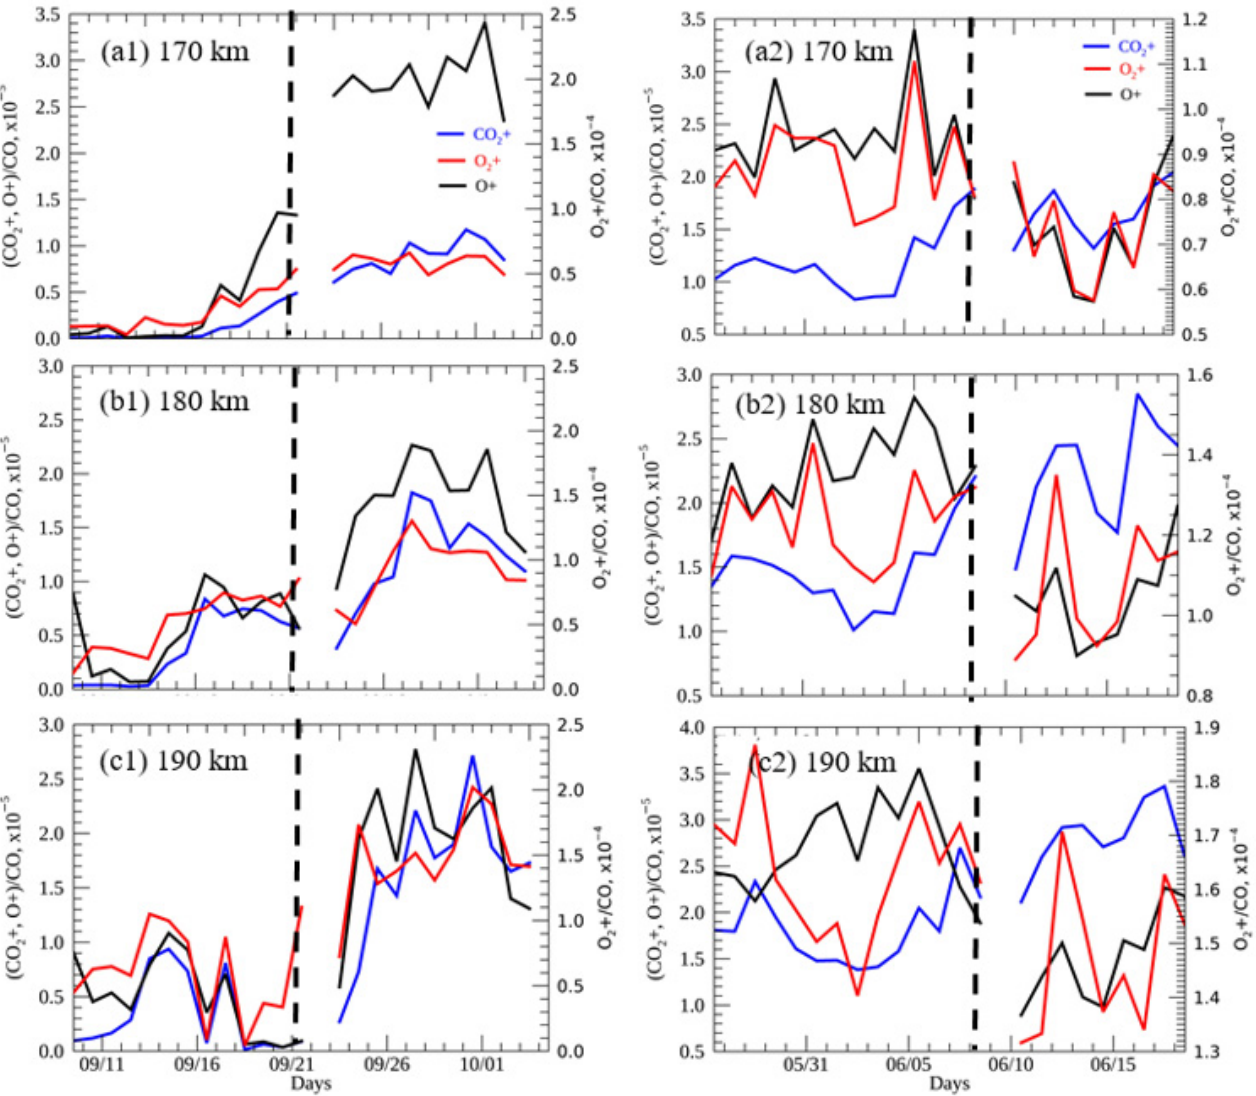
Figure 7. Ratio of (O 2+ , CO 2+ , and O + ) to CO at 170, 180, and 190 km ( a1 – c1 ) from 9 September–2 October 2016 (RDS 2016); ( a2 – c2 ) from 27 May to 17 June 2018 (GDS 2018). The vertical black line indicates the storm onset. Left axis: CO 2+ and O + to CO; right axis: O 2+ to CO.